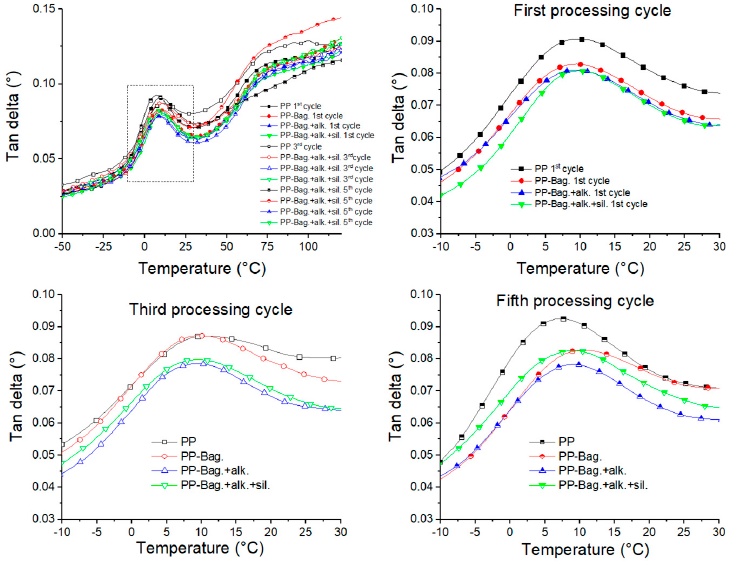
Figure 15. Temperature dependence of tan delta of neat PP and their biocomposites.